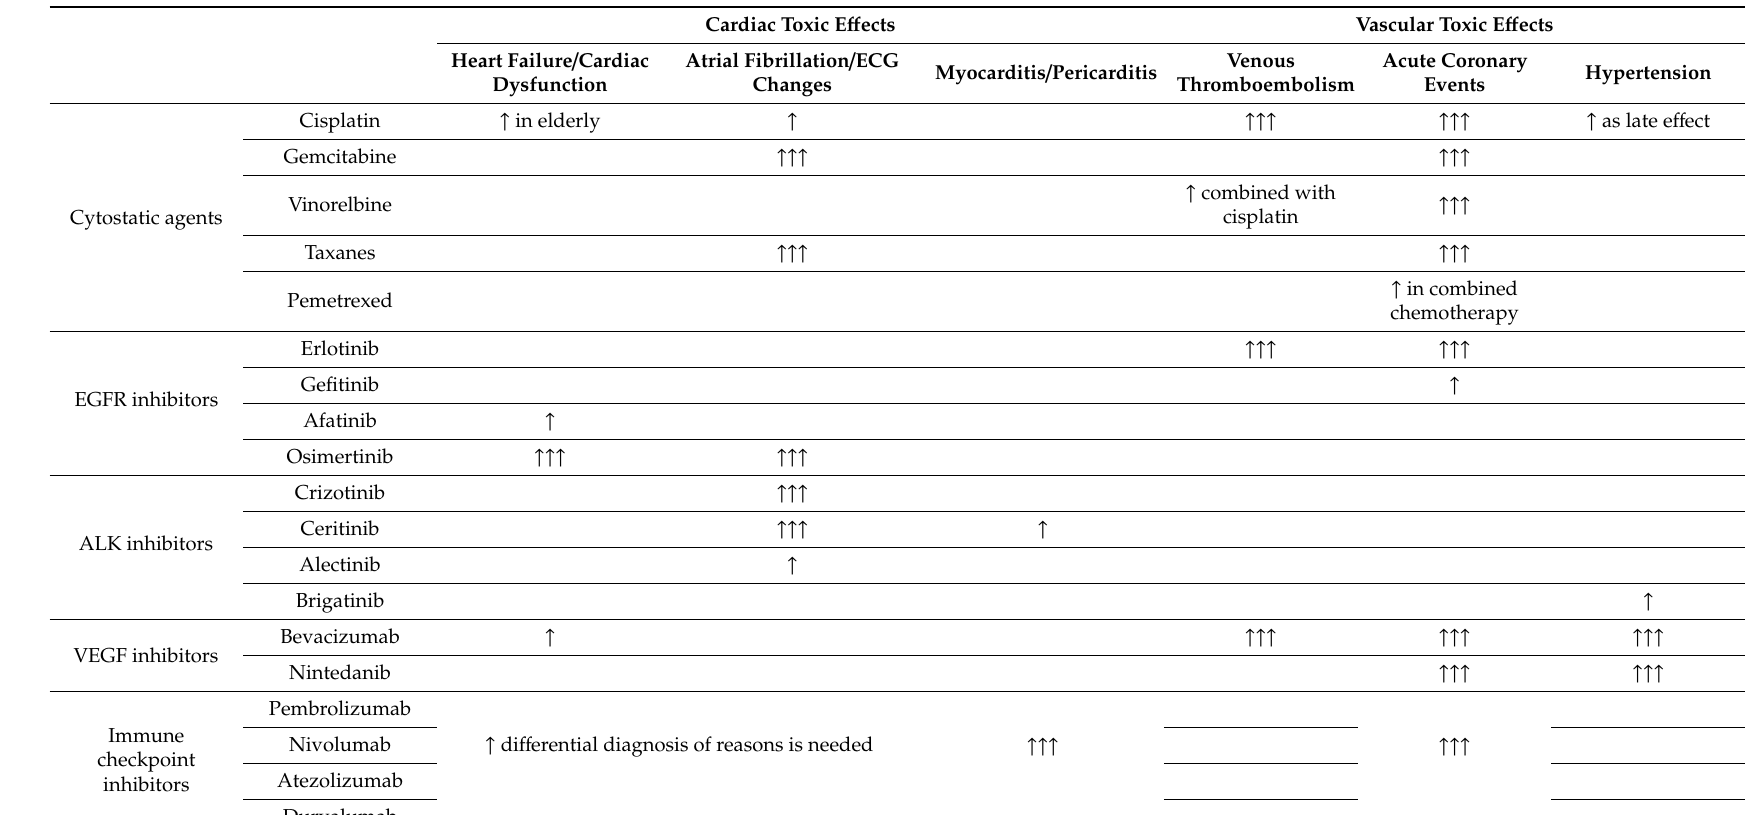
Table 1. Relationships between cardiovascular events and activity of drugs used in